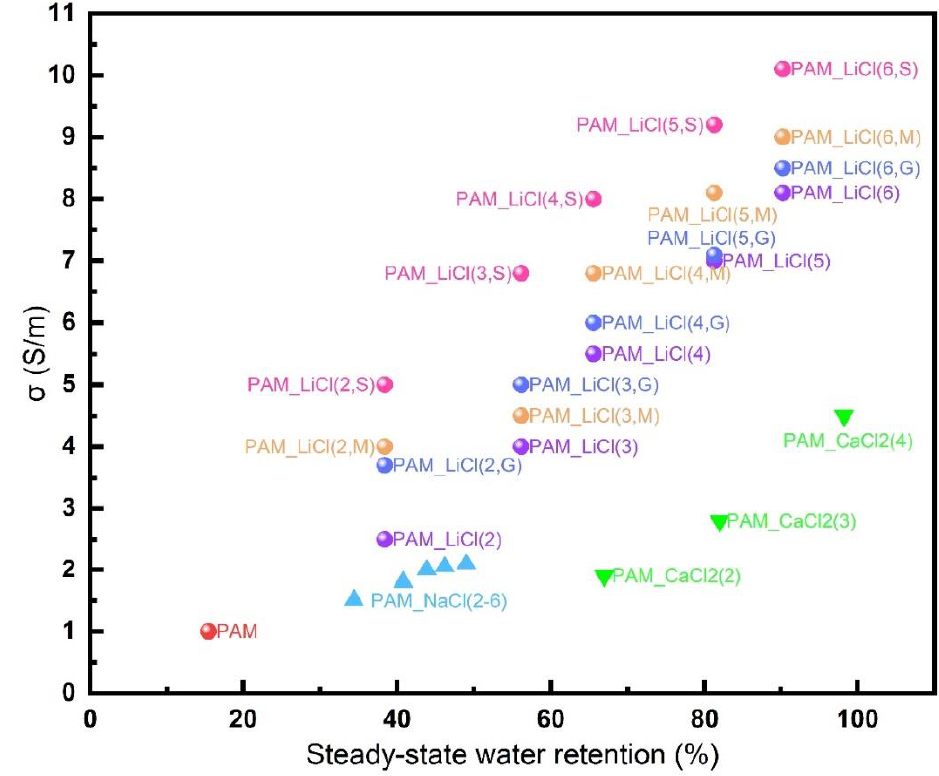
Figure 5. An Ashby diagram of hydrogel samples involved in all of the experiments.